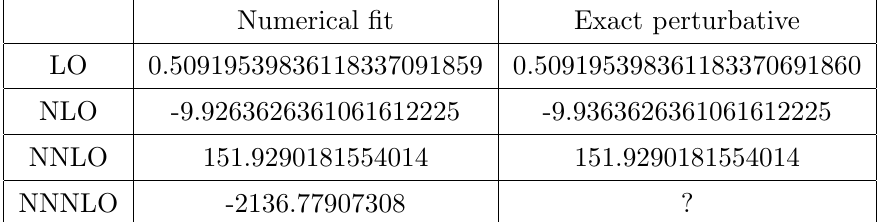
Table 1 . BFKL kernel eigenvalues calculated numerically up to NNNLO and perturbatively up to NNLO for the conformal spin n = 1 and dimension (cid:1) = 0 : 45. intercept function from section 4 calculated in the small coupling regime. The